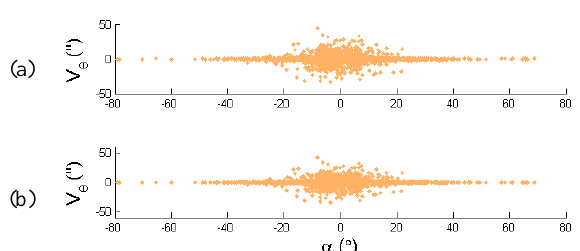
Figure 13: (a) Unmodelled 1’ collimation axis error. (b) After plane-based